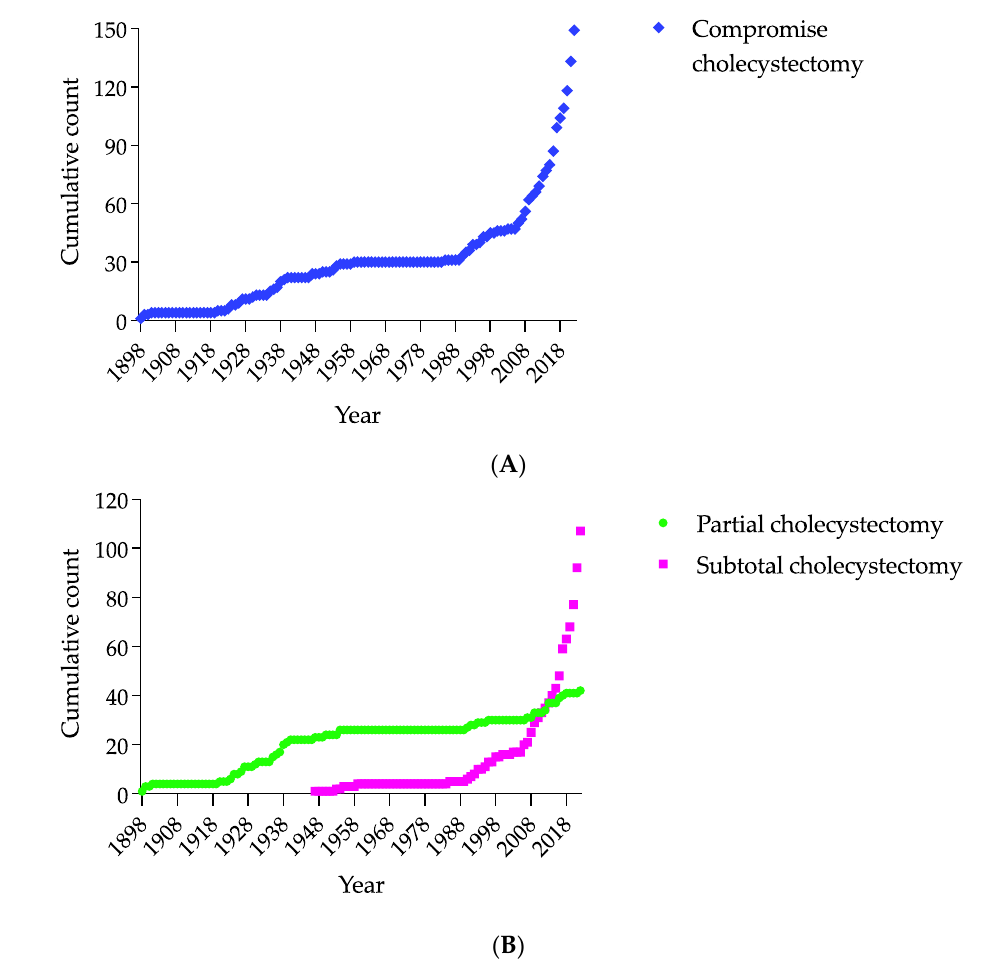
Figure 2. Cumulative annual aggregates of articles on partial resections of the gallbladder, overall and based on the term used, from 1898 to 2022. The dynamics in the cumulative number of articles on these resections, also known as compromise cholecystectomies ( A ) and the cumulative number of articles on operations named partial cholecystectomy and subtotal cholecystectomy ( B ) are shown. Figure 2A demonstrates a sharp rise in the aggregative line since 2008, when 56 articles on less-than-complete cholecystectomies were published. Figure 2B highlights the dominance of the articles with the term ‘subtotal cholecystectomy’ since 2014. In precise terms, 37 articles on partial cholecystectomies and 40 on subtotal cholecystectomies were known by 2014. Eight years later, in 2022, 42 articles on partial cholecystectomies and 107 articles on subtotal cholecystectomies were included in the cumulative count.